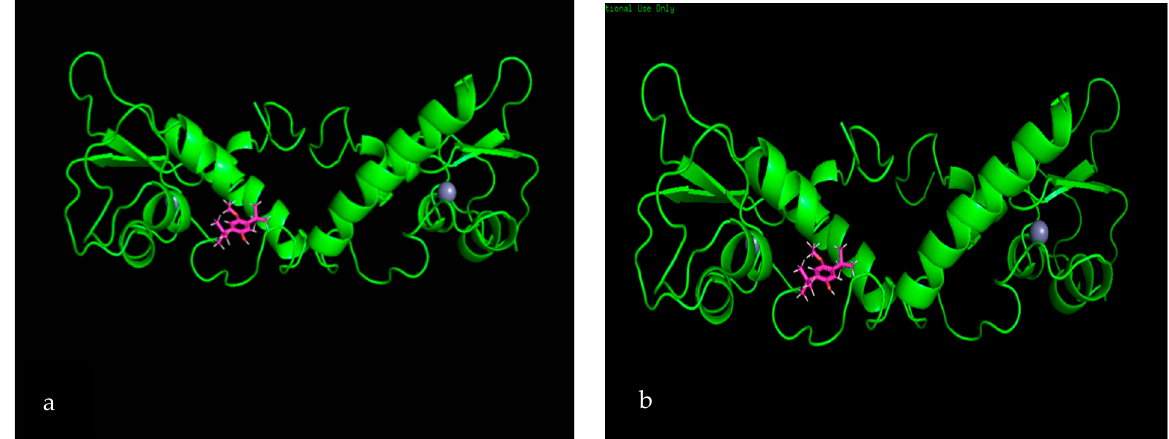
b Figure 5. The three-dimensional surface structure forming a complex between the survivin protein–ligand phenol,2,5-bis(1,1-dimethylethyl) active site 1 ( a ) and active site 2 ( b ). It clearly shows the ligand (pink) occupying the active sites’ gorge via van der Waals forces (light purple). The 4-hydroxypyridine 1-oxide (PubChem CID: 23321) ligand displayed two active sites with the survivin protein molecule, with a glide score of − 4.963 kcal / moL and − 5.039 kcal / moL, respectively, at active sites 1 and 2 (Figure 6a,b). Analysis of the active site revealed that there was a salt bridge between the ligand and the Arg18 residue of the protein, as well as a strong hydrogen bond between the ligand and Phe93.